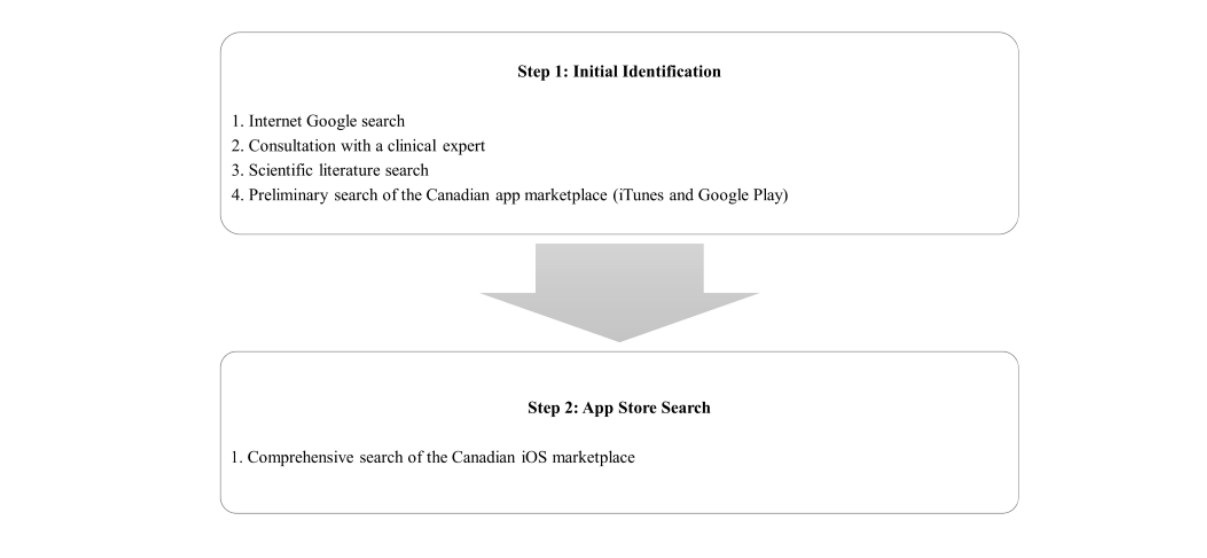
Figure 1. Summary of the steps involved in the identification phase of the communication app reviews. Note that a consultation with a clinical expert and a preliminary search were not conducted for the 2017 review. iOS: iPhone Operating